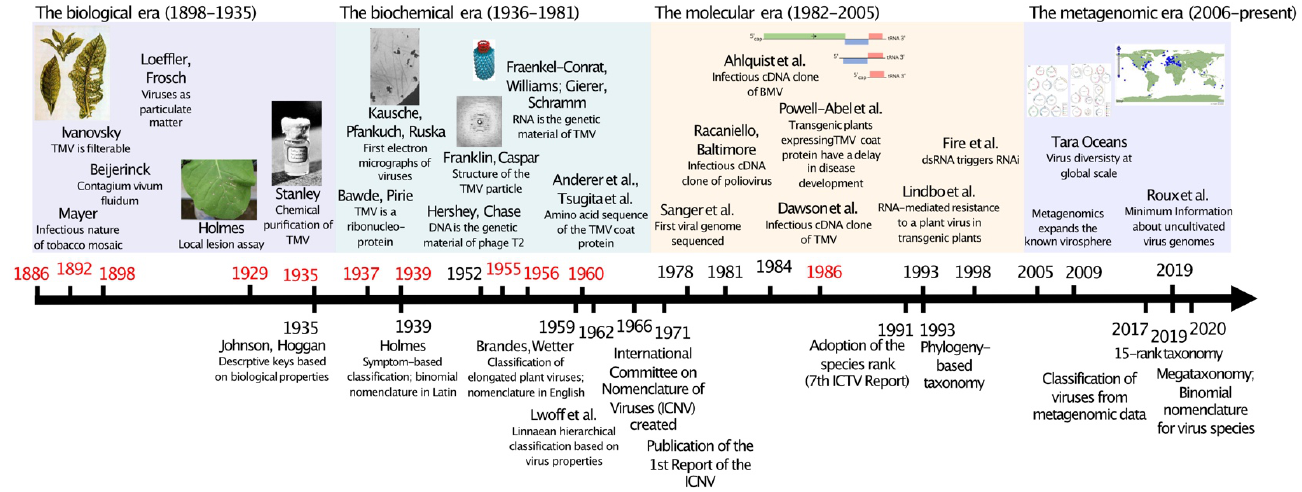
Figure 1. A timeline of virology (above the line) and virus taxonomy (below the line) milestones, from the discovery of TMV until the modern metagenomics era. Milestones involving TMV are indicated in red.